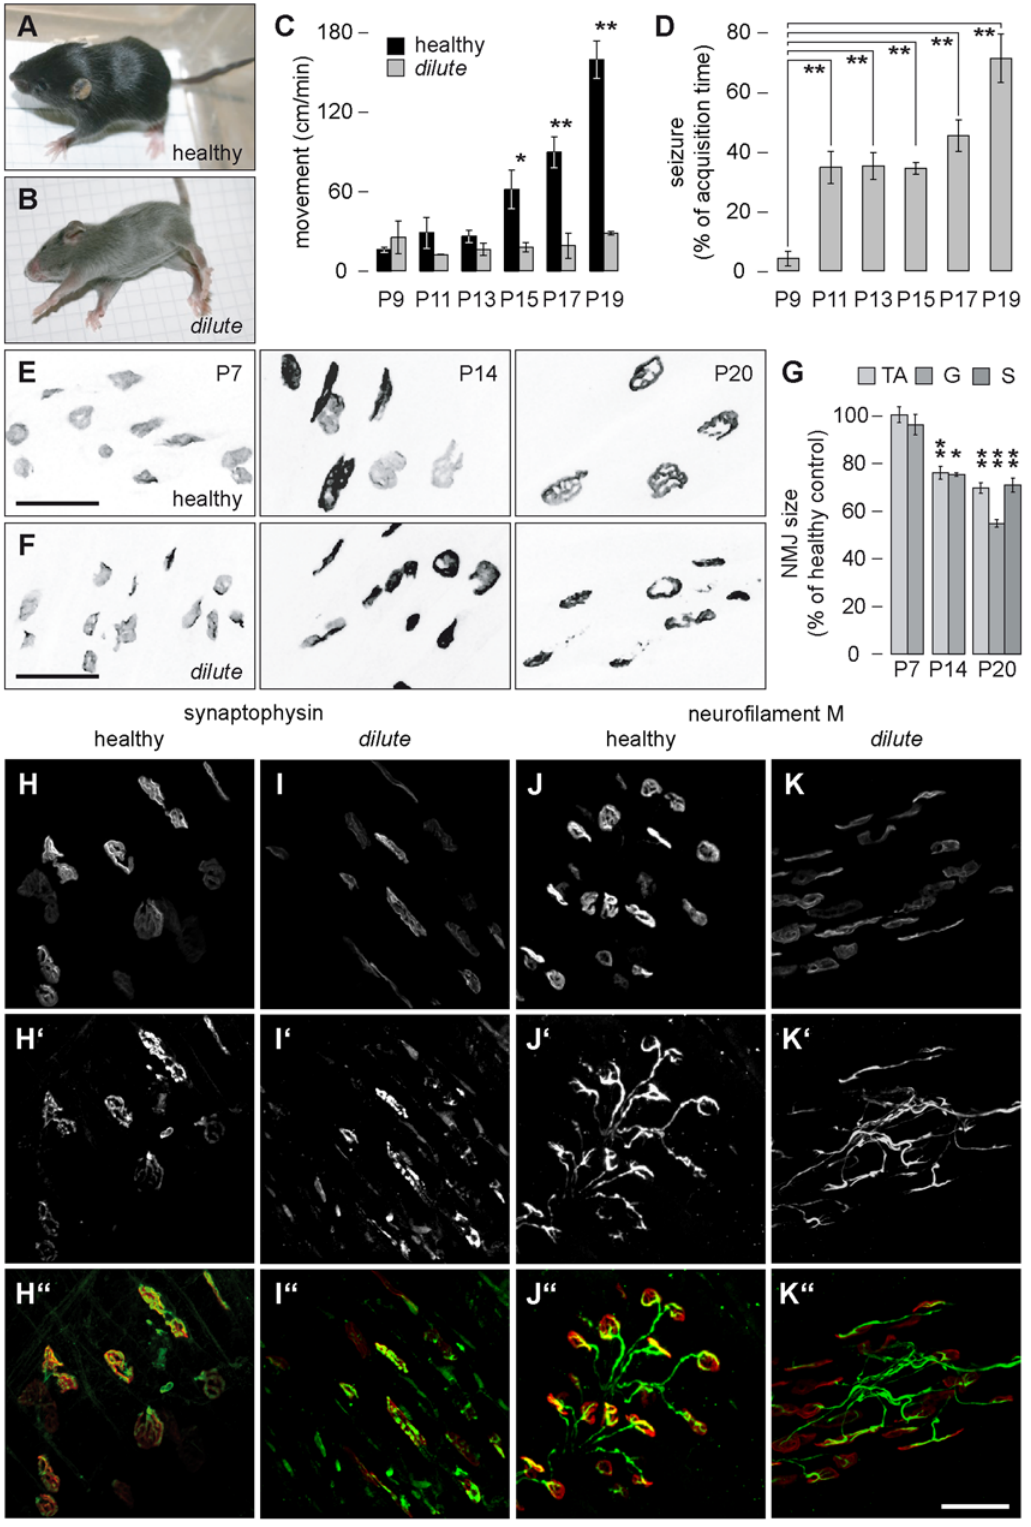
Figure 1. Aetiopathology and morphological deterioration of NMJs are temporally correlated in DLS/LeJ mice. A–D: Motility behaviour of healthy and dilute littermates was monitored from P9 to P19 using video analysis. A–B: Habitus of healthy and dilute littermates (indicated), at P14. Note light fur colour and convulsions in B. C: Quantification of unrestrained movement activity of healthy and dilute animals in a cage at the indicated ages. Columns, mean activity 6 s.e.m. (n=6 and n=3 healthy and dilute mice, respectively, from 3 different litters). D: Quantification of the fraction of observation time during which dilute animals showed clear signs of seizure at the indicated ages. Columns, mean 6 s.e.m. (P9, n=5, P13, n=4; P15, n=5; P17, n=3; P19, n=3 mice from at least 3 different litters). E–K 0 : Tibialis anterior (TA), gastrocnemius (G),